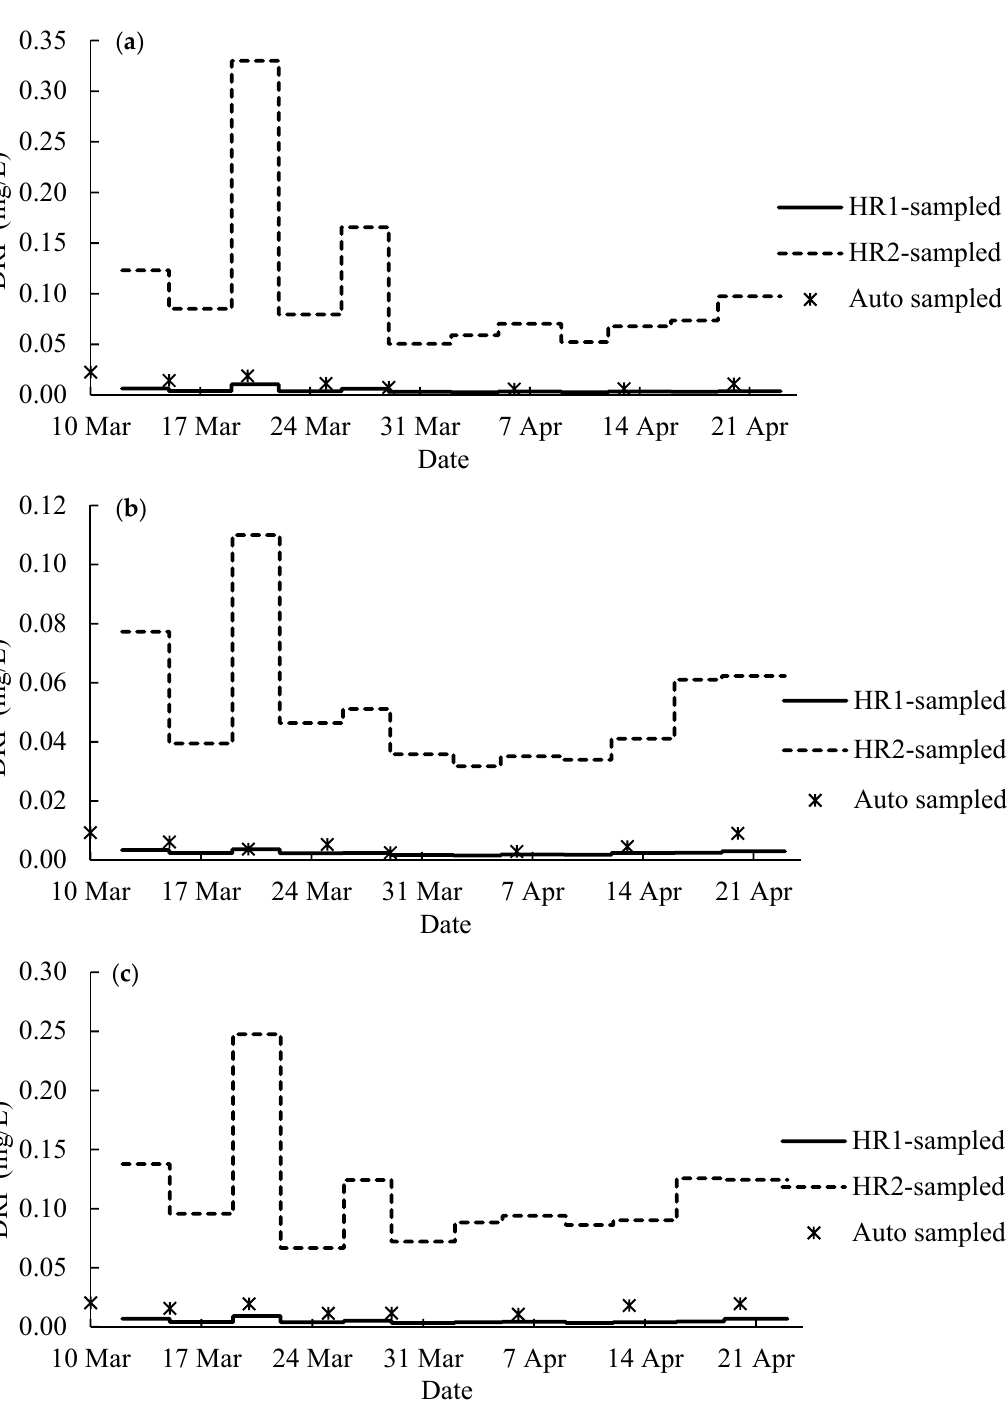
Figure 9. Phosphate concentration of tile water from ( a ) tile #4, ( b ) tile #7 and ( c ) tile #46. The line segments represent the average DRP concentration in each sampling period in 2020 calculated based on the lab sampling rates, R L . The scattered dots show the DRP concentration of tile water weekly sampled by the Agridrain system.